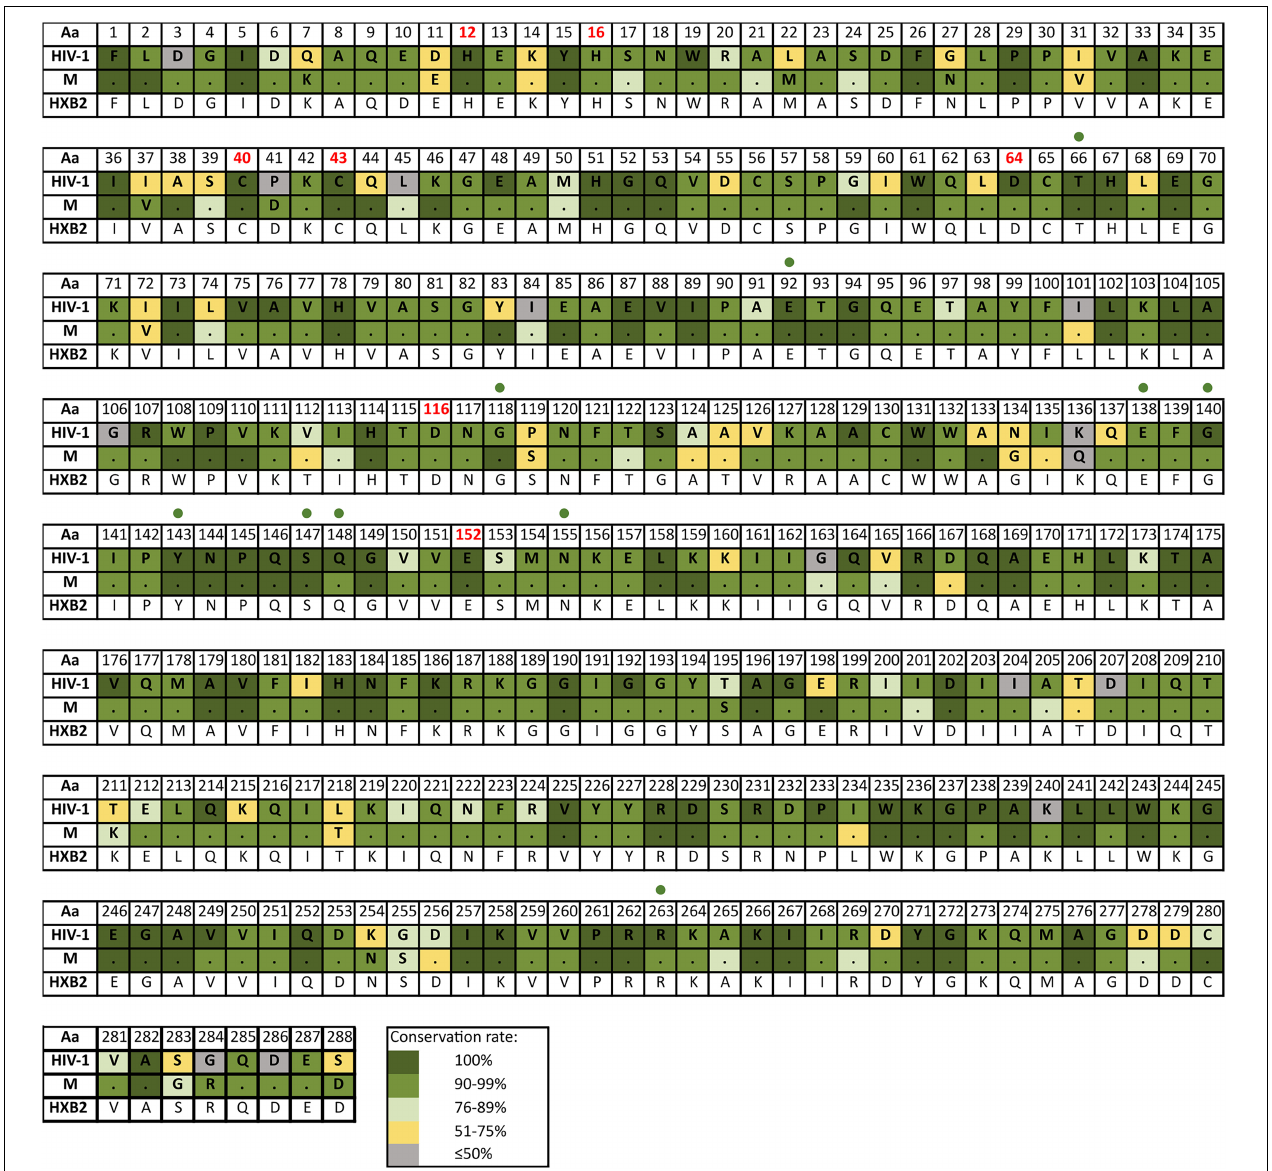
FIGURE 5 | Amino acid conservation rate along IN in HIV-1 and group M consensus. Aa, amino acid; M, group M consensus. IN, integrase (288 aa). Dots in group M represent the same aa as in HIV-1 consensus for that position. HXB2 reference sequence is described below the groups for further guidance. Colors represent the conservation rate. Residues of the zinc-binding site (His12, His16, Cys40, and Cys43) and the D–D–E motif of the catalytic domain (Asp64, Asp116, and Glu152) are highlighted in red font. Green circles indicate positions where major INSTIs DRM are located according to Stanford v9.0 (Release Notes - HIV Drug Resistance Database, 2020). Aa code according to Figure 3 .